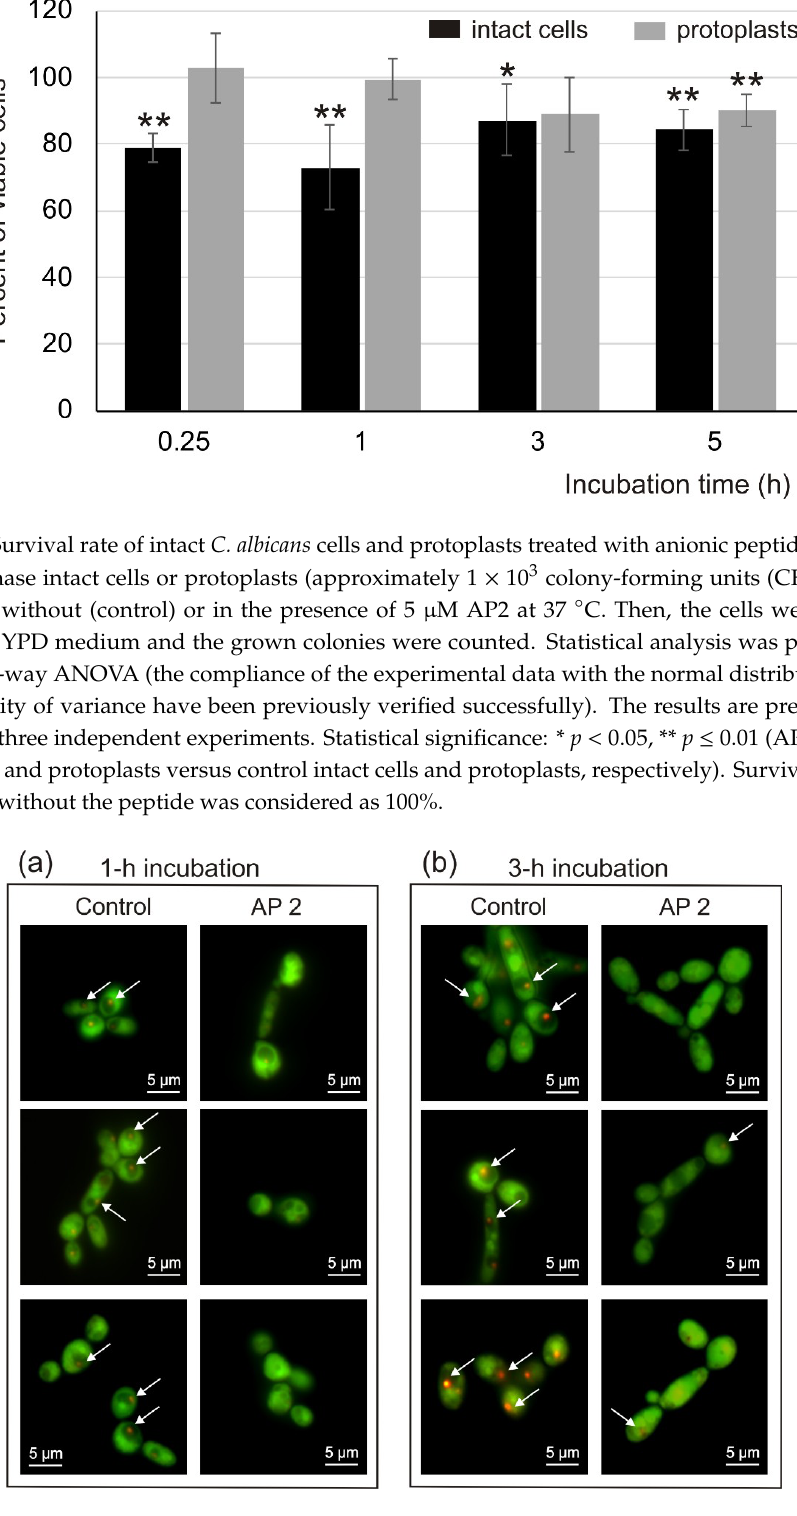
Figure 2. Effect of AP2 on C. albicans metabolic activity. The log-phase cells were incubated without (control) and in the presence of 5 μM AP2 at 37 °C for 1 h ( a ) and 3 h ( b ). The cells were then stained with FUN1 fluorescent dye and imaged using a laser scanning confocal microscope LSM 5 PASCAL. Metabolically active cells contain intravacuolar red-orange structures (indicated by white arrows). Representative images are presented.